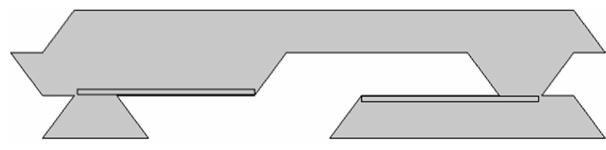
Figure 3. Domain of the piezoelectric pump .